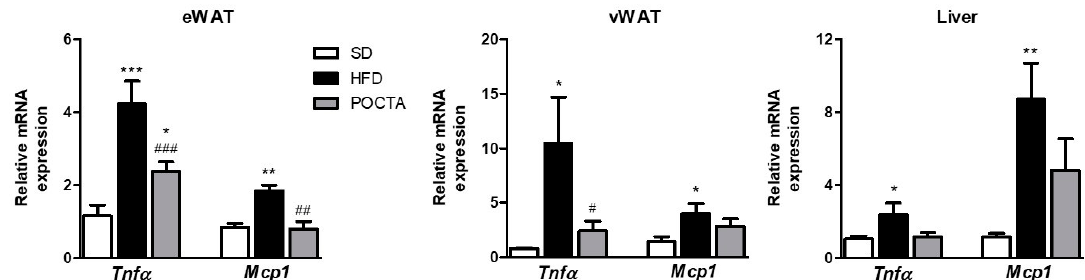
Figure 3. The effect of a POCTA diet on mRNA levels of pro-inflammatory cytokines (Tnf- α ) and chemokines (Mcp1) in epididymal white adipose tissue (eWAT) ( A ), epididymal white adipose tissue (vWAT) ( B ), and liver ( C ), of mice fed the SD, HFD, or POCTA diet. Values are mean ± SEM ( n = 5–7) and are normalized relative to the control group. * p < 0.05, ** p < 0.01, *** p < 0.001 vs. SD; # p < 0.05, ## p < 0.01, ### p < 0.001 vs. HFD.